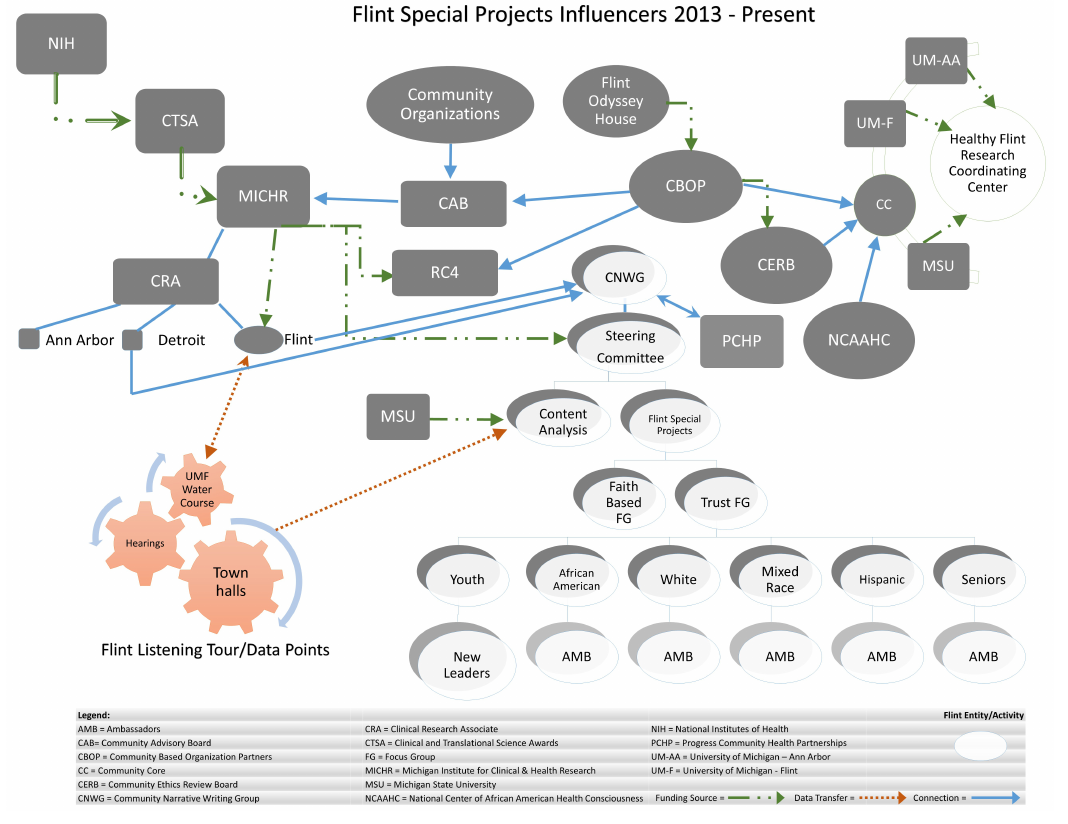
Figure 1. Principle influencers leading to the development and success of the Flint Special Projects research team. In dark grey bubbles we show the community context and influencers to the development of the Flint Special Projects efforts. In light grey ellipses we show the components and derivatives of the Flint Special Projects’ research